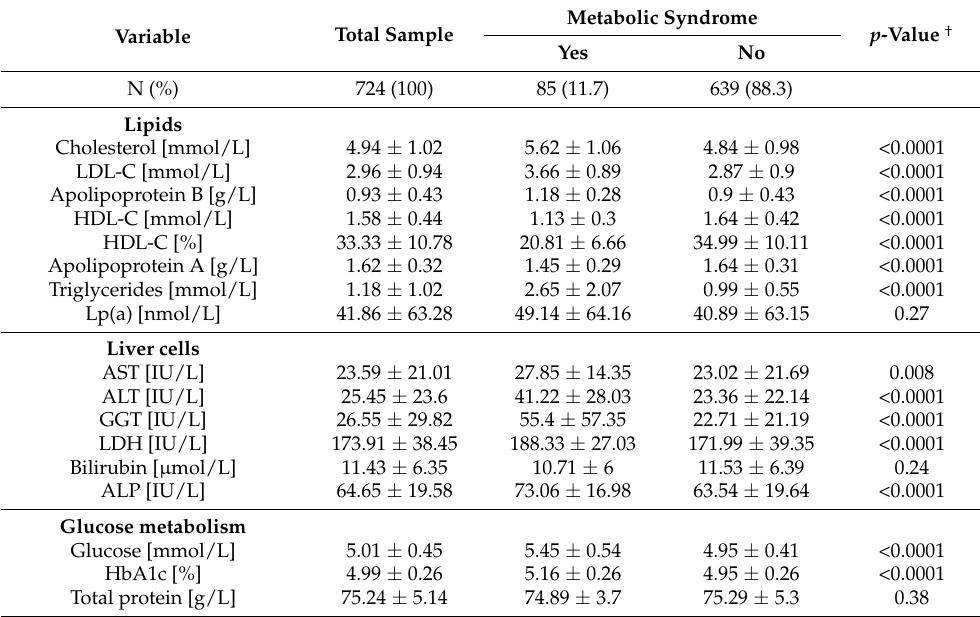
Table 2. The comparison of laboratory findings between young adult patients with and without MS.